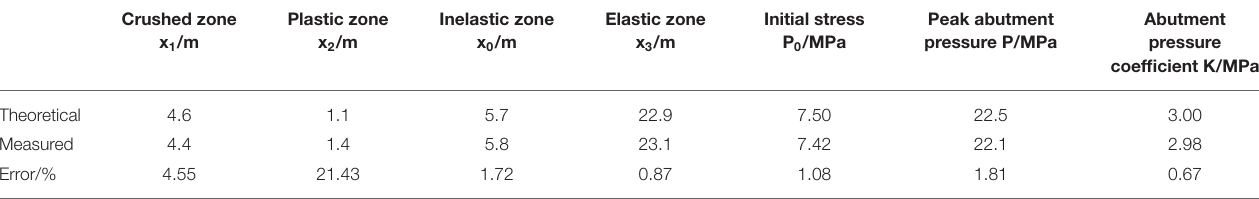
TABLE 3 | Comparison of theoretical calculations and field